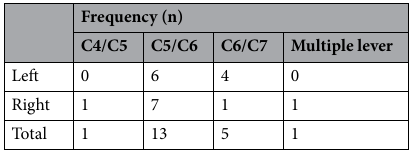
Table 1. Preoperative diagnostic imaging features (Operated spinal level and side of the